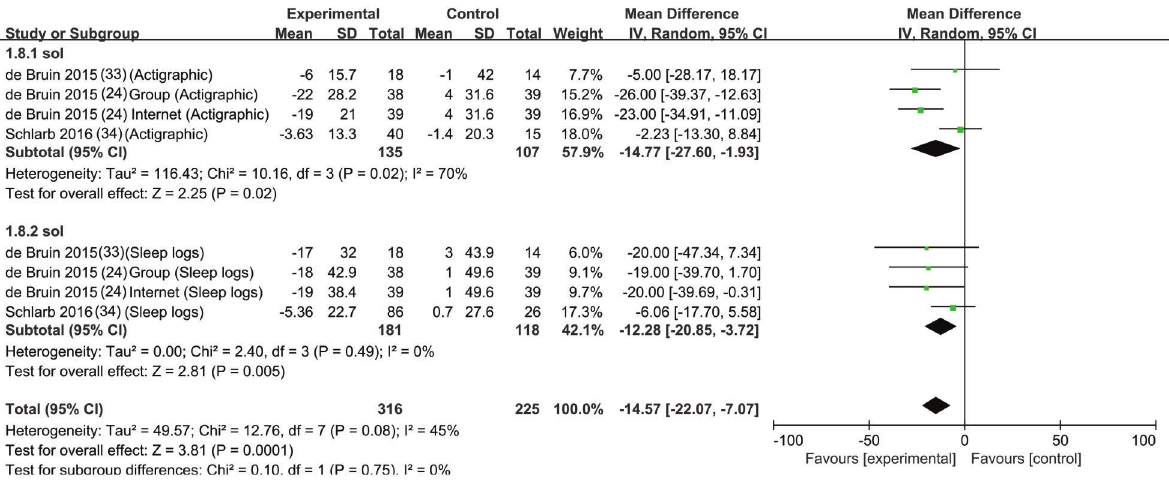
Figure 2. Meta-analysis of the effect of cognitive behavioral therapy for insomnia on sleep onset latency (SOL).